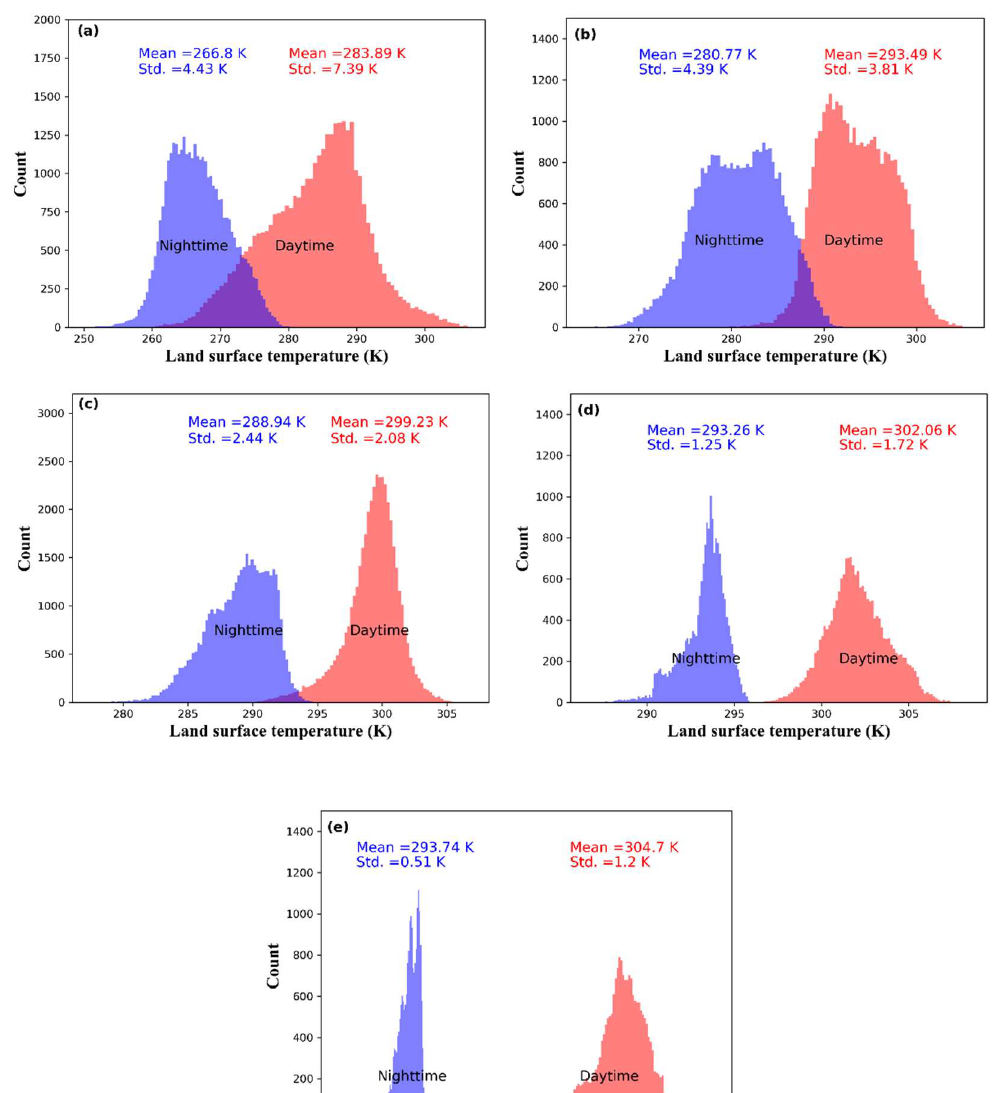
Figure 2. Annual average the mean annual surface temperature (MAST) during the period 2000 to 2017. ( a ) Daytime; ( b ) Nighttime.